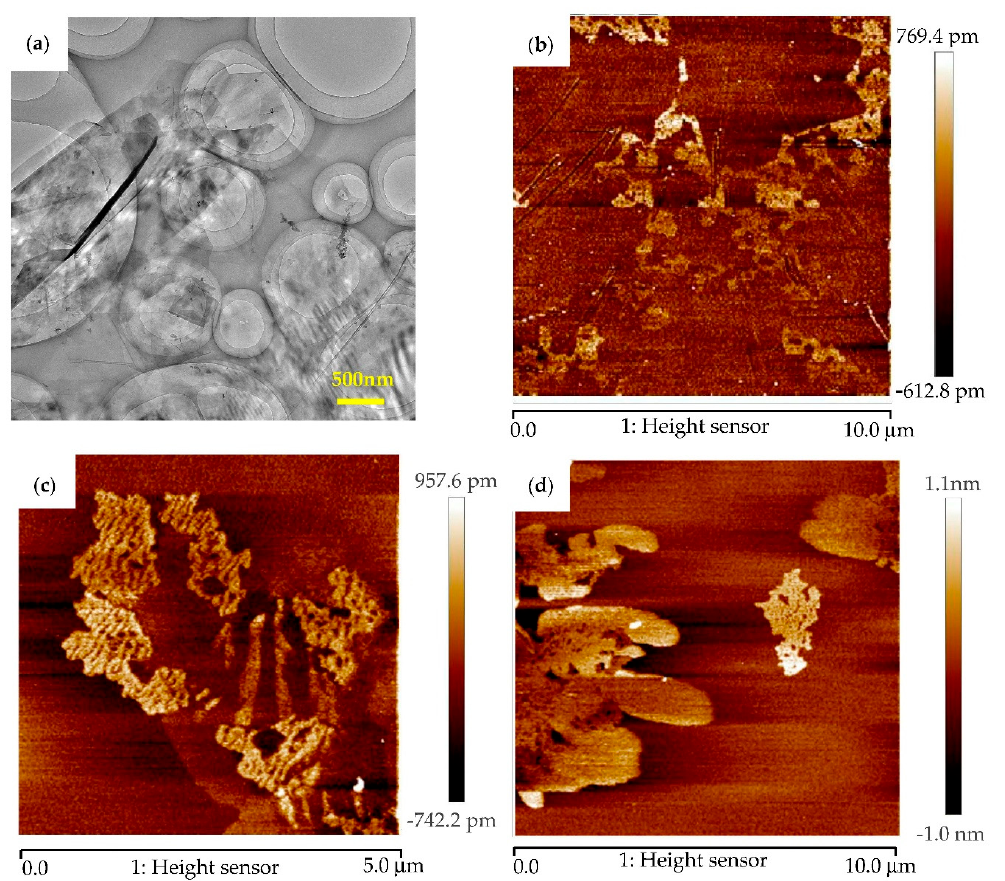
Figure 4. ( a ) TEM of graphene and AFM images of ( b ) graphene; ( c ) Cu-decorated graphene and ( d ) Ni-decorated graphene.